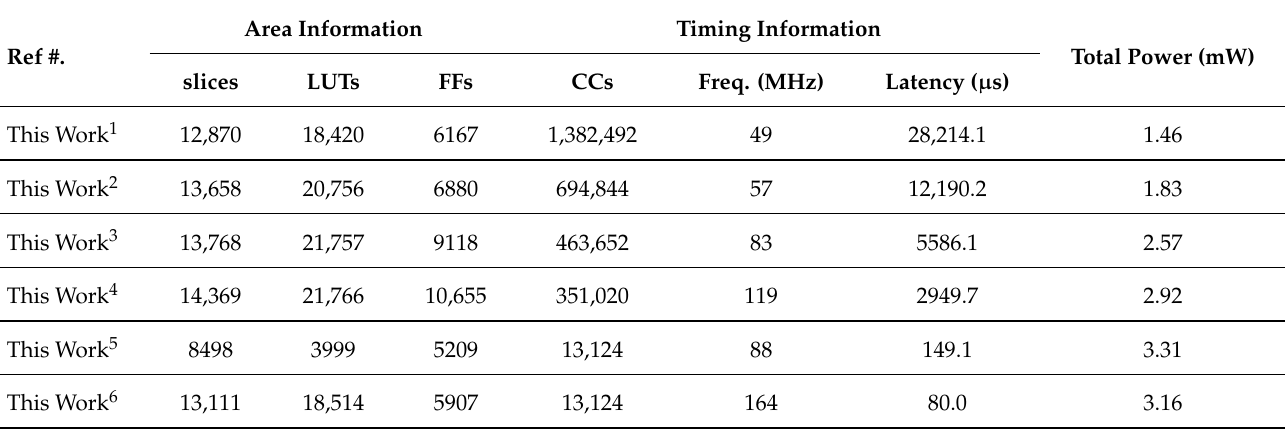
Table 5. Implementation results of the BHC model of ECC, constructed in 2018, over GF ( 2 233 )